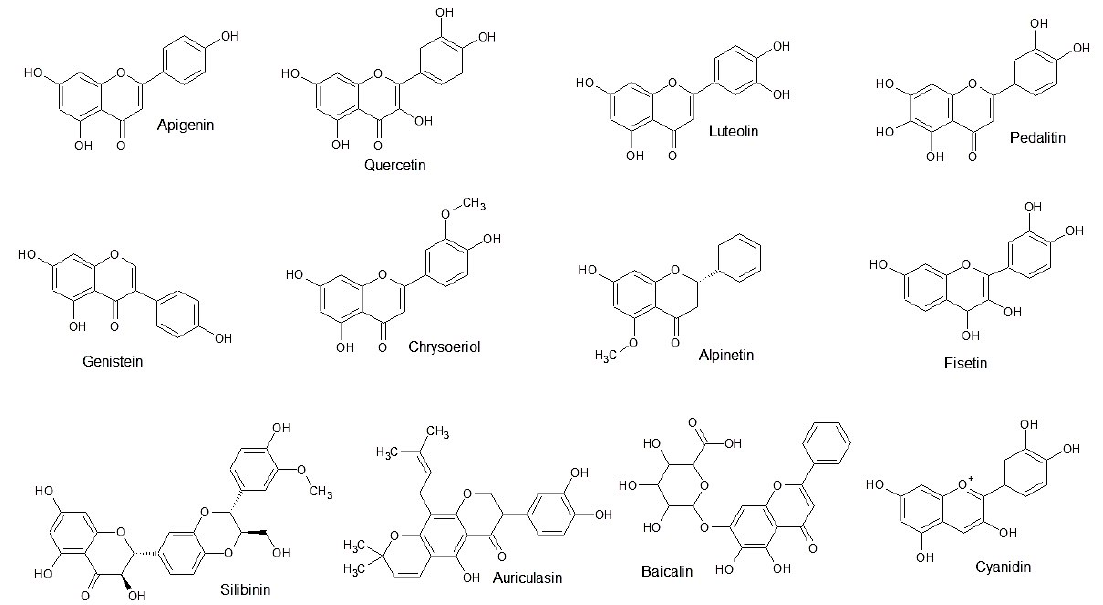
Figure 3. Chemical structures of selected flavonoids.